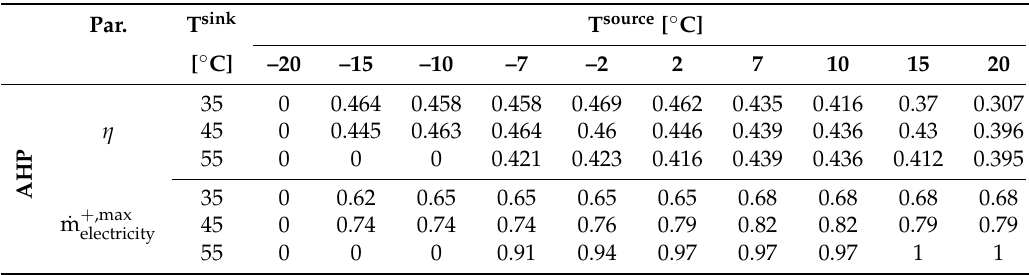
Table A3. Default parameters values for the AHP second-law efficiency and part-load limit, evaluated from [49].